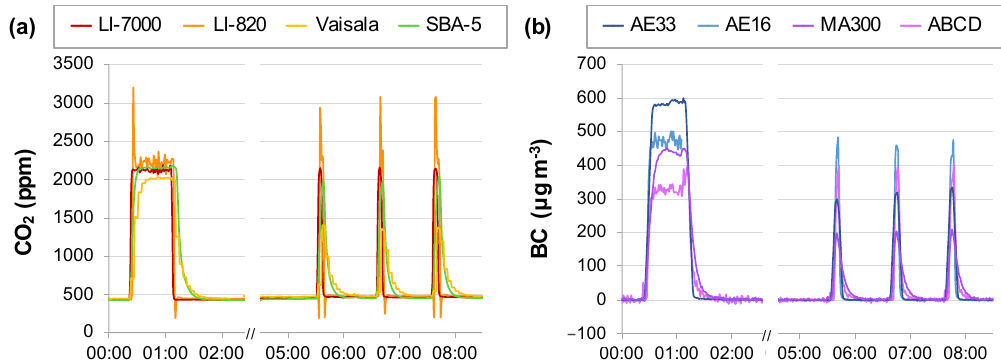
Figure 1. Example concentration time series from laboratory experiments. The time series show the varied responses of the ( a ) CO 2 and ( b ) BC sensors tested in this experiment during steady-state and peak concentration events. For example, the higher cost LI-7000 accurately responds to the initial step change in CO 2 concentration, while the lower cost LI-820 initially overshoots to ~3200 ppm before returning to the concentration plateau at ~2100